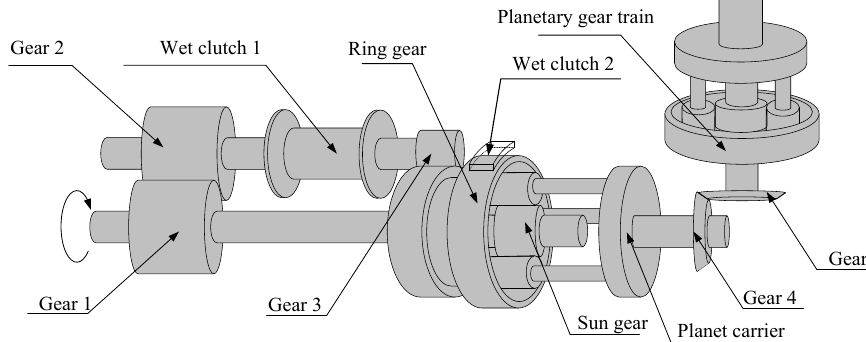
Figure 1. The variable speed transmission system configuration of helicopter